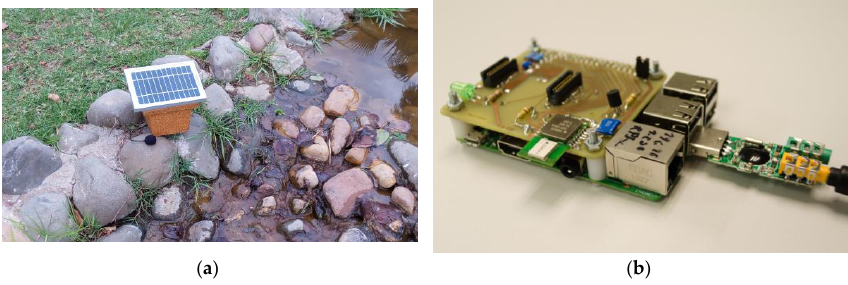
Figure 2. Current prototype of the acoustic sensor: ( a ) External enclosure: ( b ) Sensor board.